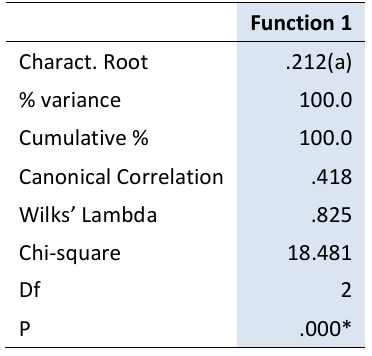
Table 9: Parameters of the isolated discriminant